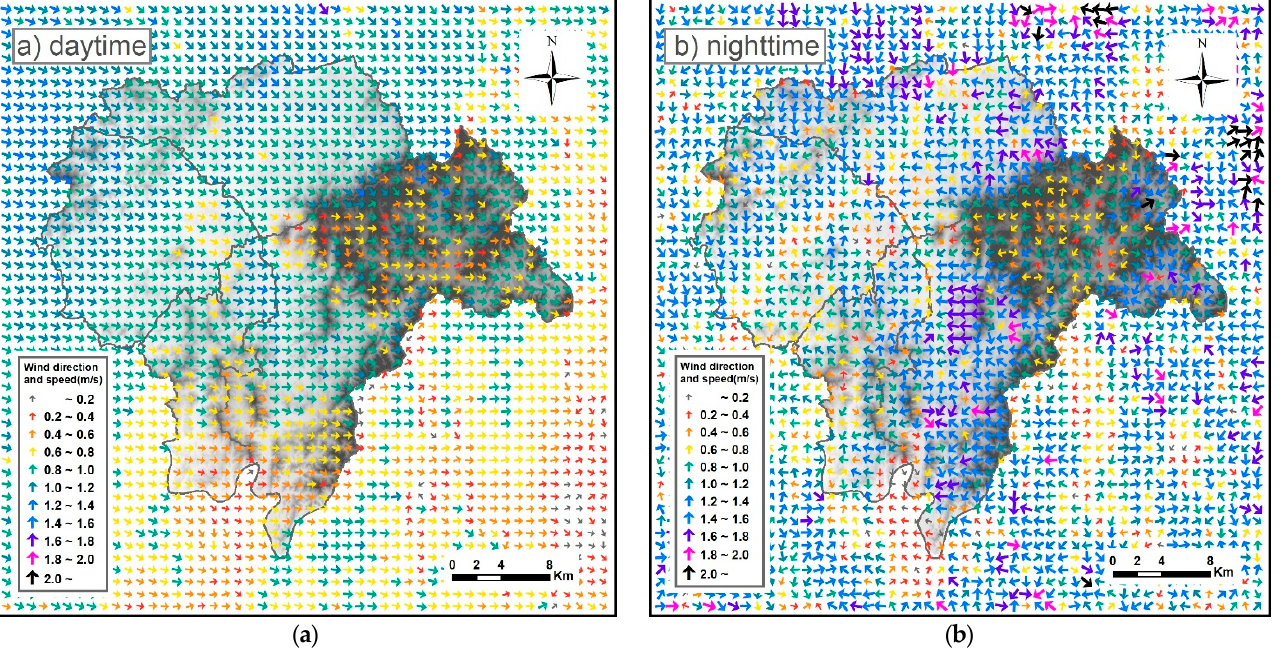
Figure 4. Annual wind field map of Cheongju-si, Korea, in the daytime ( a ) and nighttime ( b ) in 2016. Westerly, southwesterly, and southerly winds were predominant in the spring. In the summer, southwesterly and southerly winds prevailed, except for the northern and western regions where northwesterly and westerly winds were predominant. Northerly and northeasterly winds prevailed in the autumn, while strong northwesterly winds pre- vailed in winter (Figure 5).